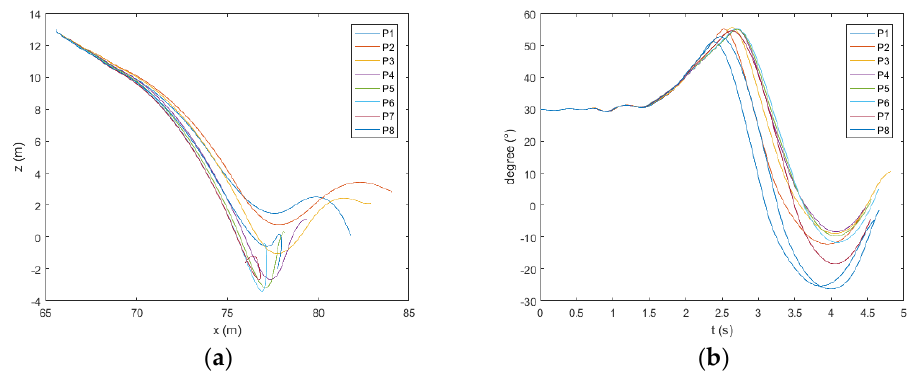
Figure 17. Trajectory ( a ) and pitch ( b ) of the lifeboat freefall when the wave height is 5 m.